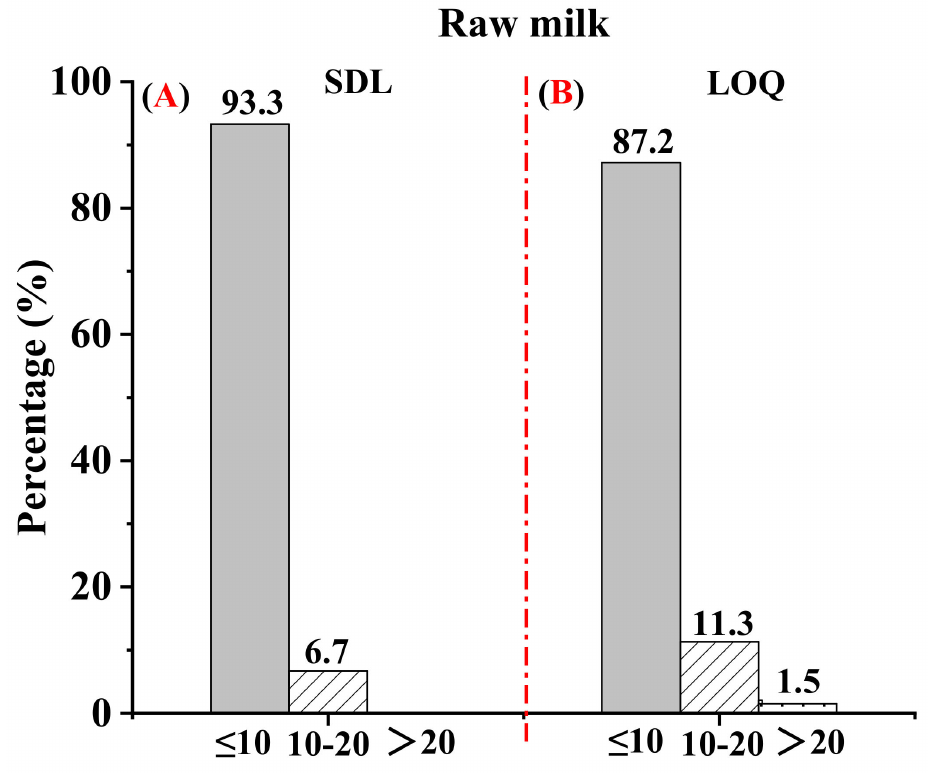
Figure 5. The distribution of the screening and quantification limits of pesticides in raw milk: ( A ) SDL distribution of pesticides in raw milk; ( B ) LOQ distribution of pesticides in raw